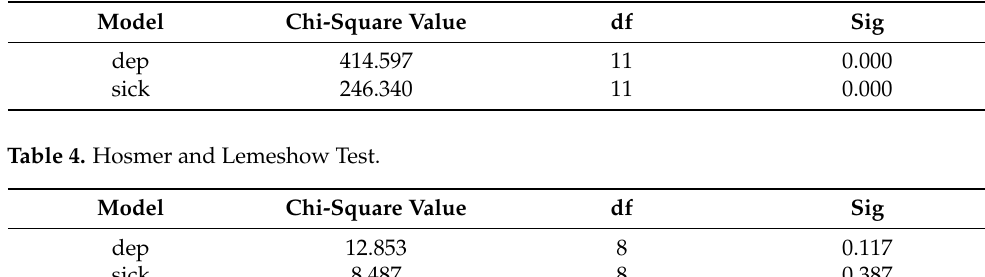
Table 3. Comprehensive Test of Model Coefficients.